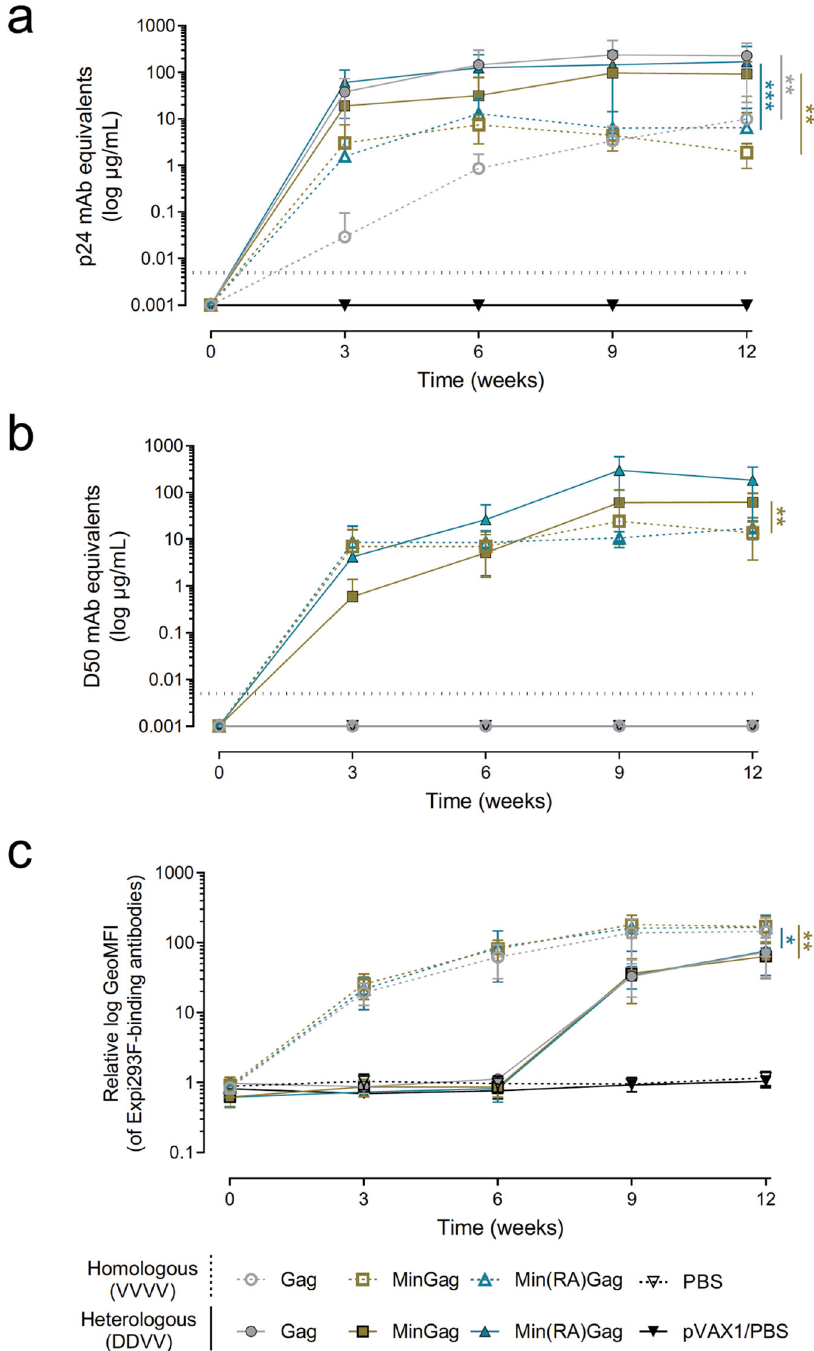
Fig. 3 Humoral responses induced by homologous and heterologous immunisation regimens. C57BL/6JOlaHsd mice were immunised at weeks 0, 3, 6, and 9 with a homologous (VVVV; dashed line) or heterologous (DDVV; solid line) regimens consisting on Gag-VLPs (grey rounds; n = 10), MinGag-VLPs (gold squares; n = 10) or Min(RA)Gag-VLPs (blue triangles; n = 10) and a pVAX1/PBS control or PBS control (black triangles; n = 4). a Concentration of anti-Gag IgG in mouse sera determined by ELISA. b Concentration of anti-Min IgG in mouse sera determined by ELISA. c Concentration of IgGs against Expi293F host cell proteins analysed by FACS. Data are presented as mean ± 95%CI for the ELISA results and geo-MFI ± SD for the FACS results. Statistical differences at week 12 were found using a Kruskal – Wallis test with Dunn ’ s correction (* p < 0.05; ** p < 0.01; *** p < albeit no signi fi cant differences were found between VLP constructs (Supplementary Fig. 6a, b). Moreover, no T-cell (Supplementary Fig. 5a, b). responses were detected against the MPER 44,45 , whereas weak T-cell responses against Min and Gag proteins were evaluated by IFN- γ ELISpot using cryopreserved murine splenocytes. As responses were elicited against Min in MinGag-VLP-immunised anticipated, T-cell responses were mostly directed against Gag, animals in the heterologous regimen (Supplementary Fig. 6a, b).